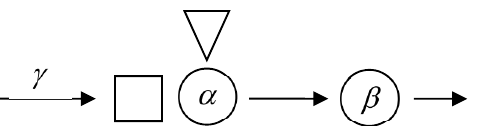
Figure 1. A non-product-form system with a Poisson flow of customers arriving at the second server.